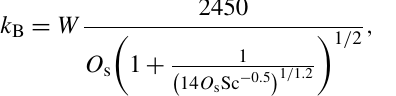
(Table 1: S07 , DM18 , SD21 , and SD21-fit ) following Keeling (1993) and Woolf et al. (1997, 2005). Our adapted model for lake includes a refined parameterisation of the wave action term ε w from S07 along with the bubble term